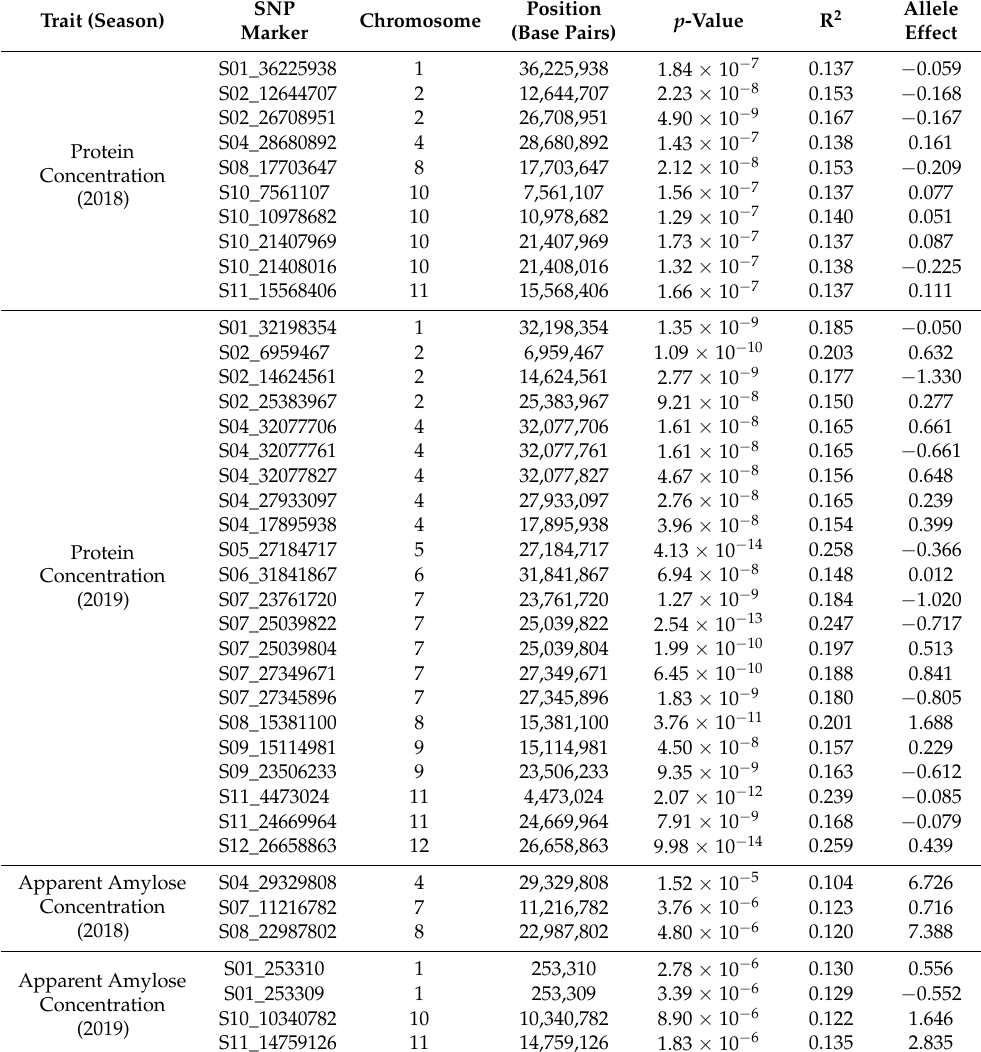
Table 2. Significant SNPs detected by GWAS using TASSEL Mixed Linear Model (MLM) associated with milled grain protein and apparent amylose concentrations from the 2018 and 2019